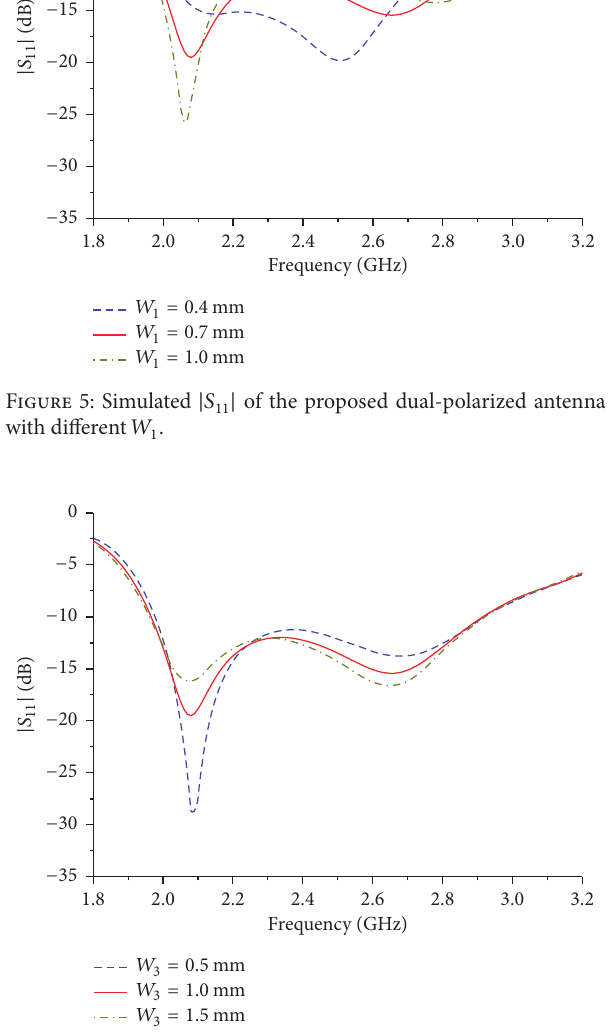
Figure 6: Simulated |𝑆 11 | of the proposed dual-polarized antenna with different 𝑊 3